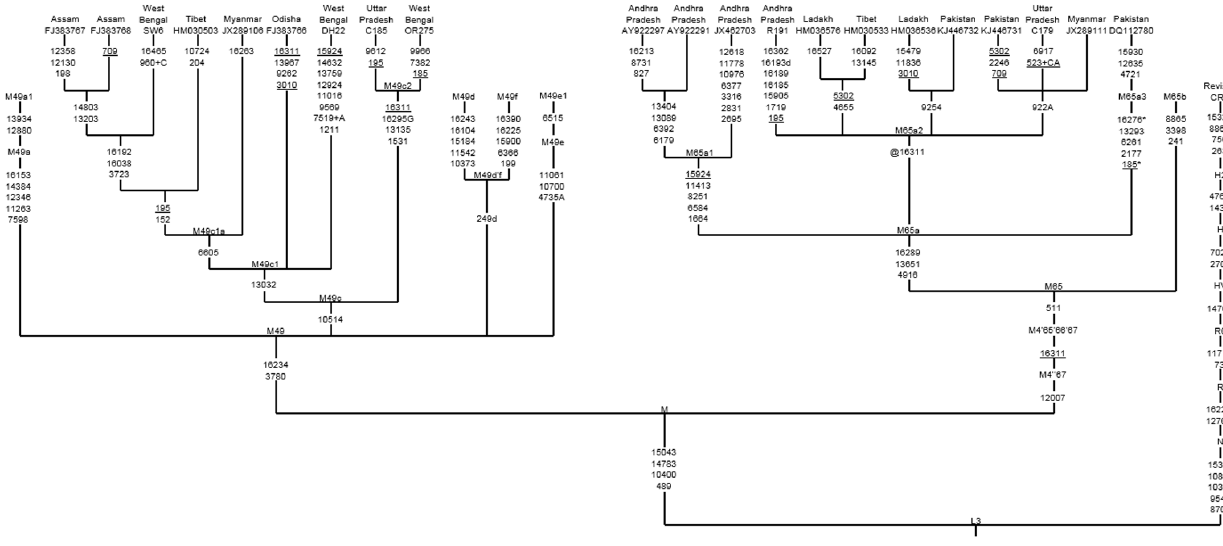
Figure 1. Maximum parsimony tree of entire mtDNA genomes belonging to ancient Mesopotamian haplogroups M49 and M65 . Mutations are scored relative to the revised Cambridge reference sequence (rCRS) [5] and displayed along the branches. The prefix ‘‘@’’ indicates back mutation, recurrent mutations are underlined, transversions have a base suffix, ‘‘d’’ deletions and ‘‘ + ’’ insertions, and the poly(C) region in HVS1 and -2 as well as 16519 is excluded. The geographic origin of the sample and the accession number which is retrieved from the publication are denoted on top of the branches.